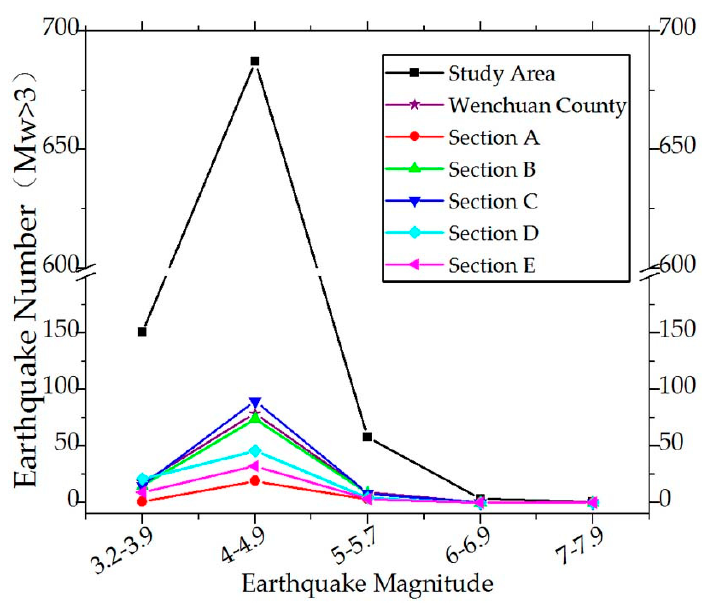
Figure 13. Relationship between earthquake magnitude (Mw > 3) and earthquake number in the study area from 2002 to 2016 (source: USGS).